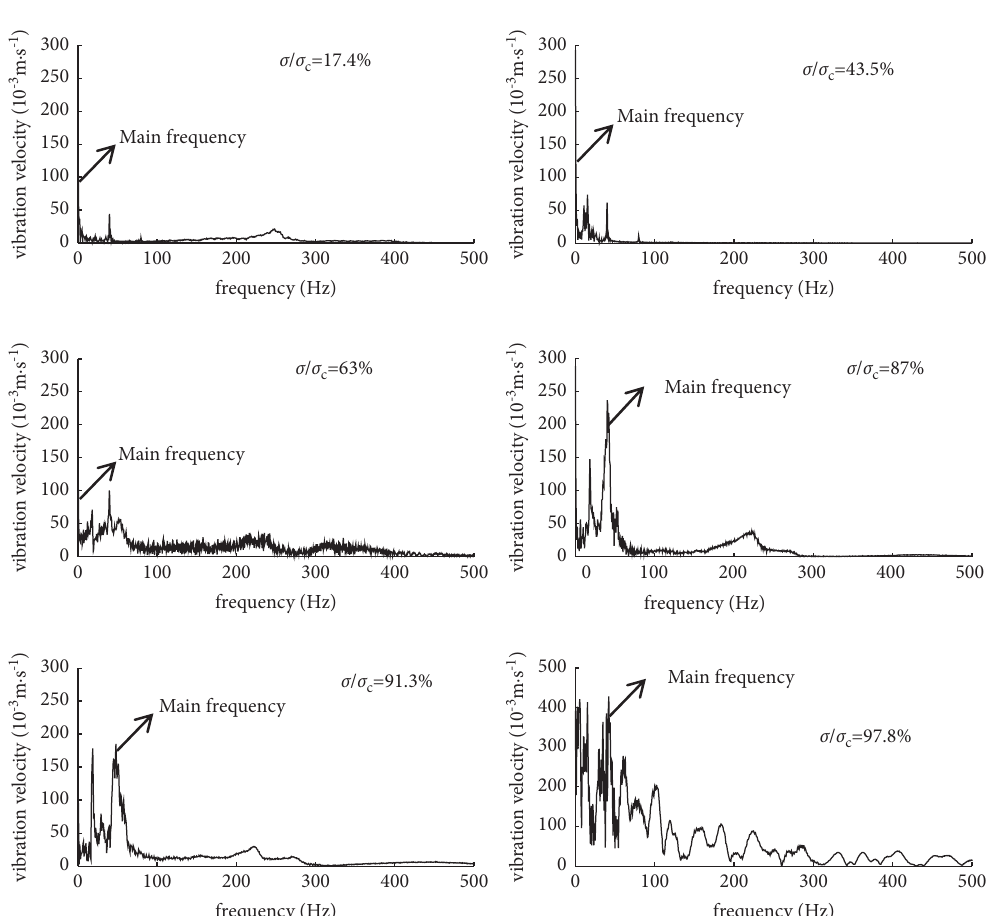
Figure 10: Microseismic signals spectrum of coal in different stages when the loading rate is 0.01mm/s. ×10 -5